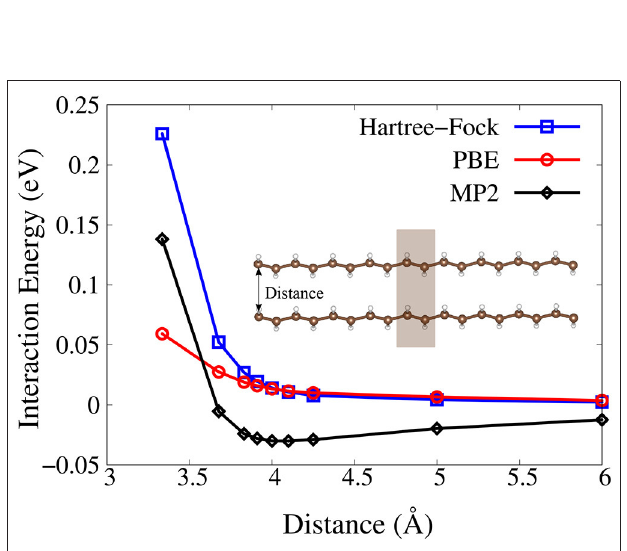
FIGURE 2 | Interaction energy as functions of the distance between two trans-polyacetylene chains as predicted by the Hartree-Fock (blue), PBE (red), and MP2 (black) method. The unit cell is marked with shaded